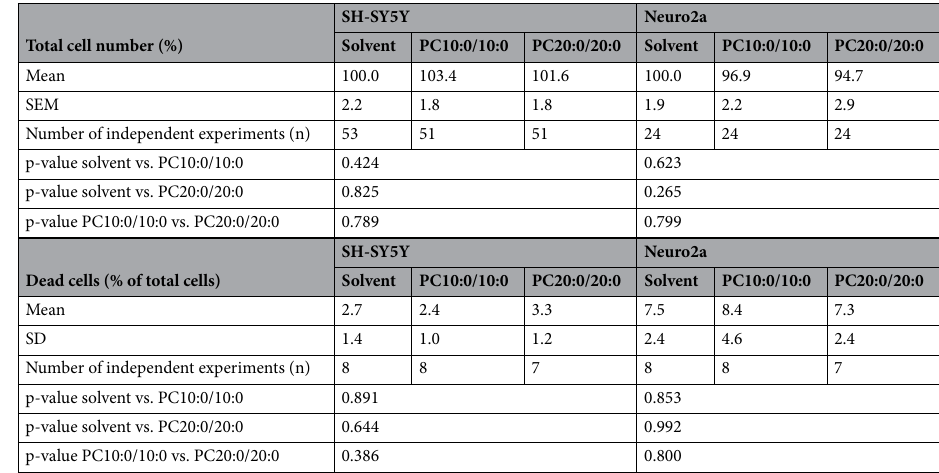
Table 1. Impact of PC10:0/10:0, PC20:0/20:0 or solvent on total cell numbers and cell viability. Total cell number (%): DAPI signal correlating with total cell number of all wells used for the measurements shown in Figs. 1a–e and 2a,b. Dead cells (%): the percentage of dead cells after treatment with the solvent EtOH (0.2%), PC10:0/10:0 or PC20:0/20:0 (10 µM) for 18 h was calculated after determination of the total cell number and the number of dead cells utilizing DAPI (1 µg/ml) and Ethidium homodimer-1 (10 µM), respectively. The statistical significance was calculated by one-way ANOVA followed by post hoc testing using Tukey’s test, no significant differences were observed. SEM standard error of the mean, SD standard